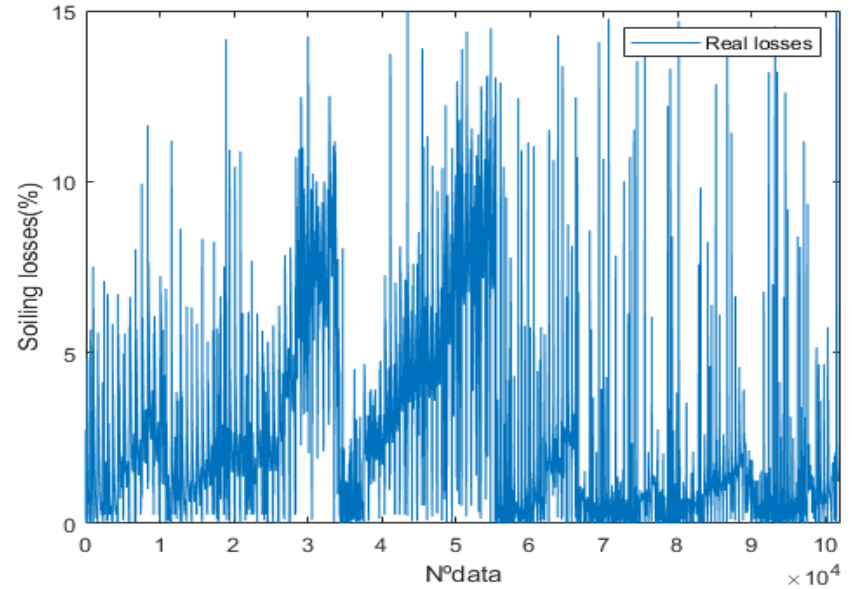
Figure 7. Real losses without Isc.